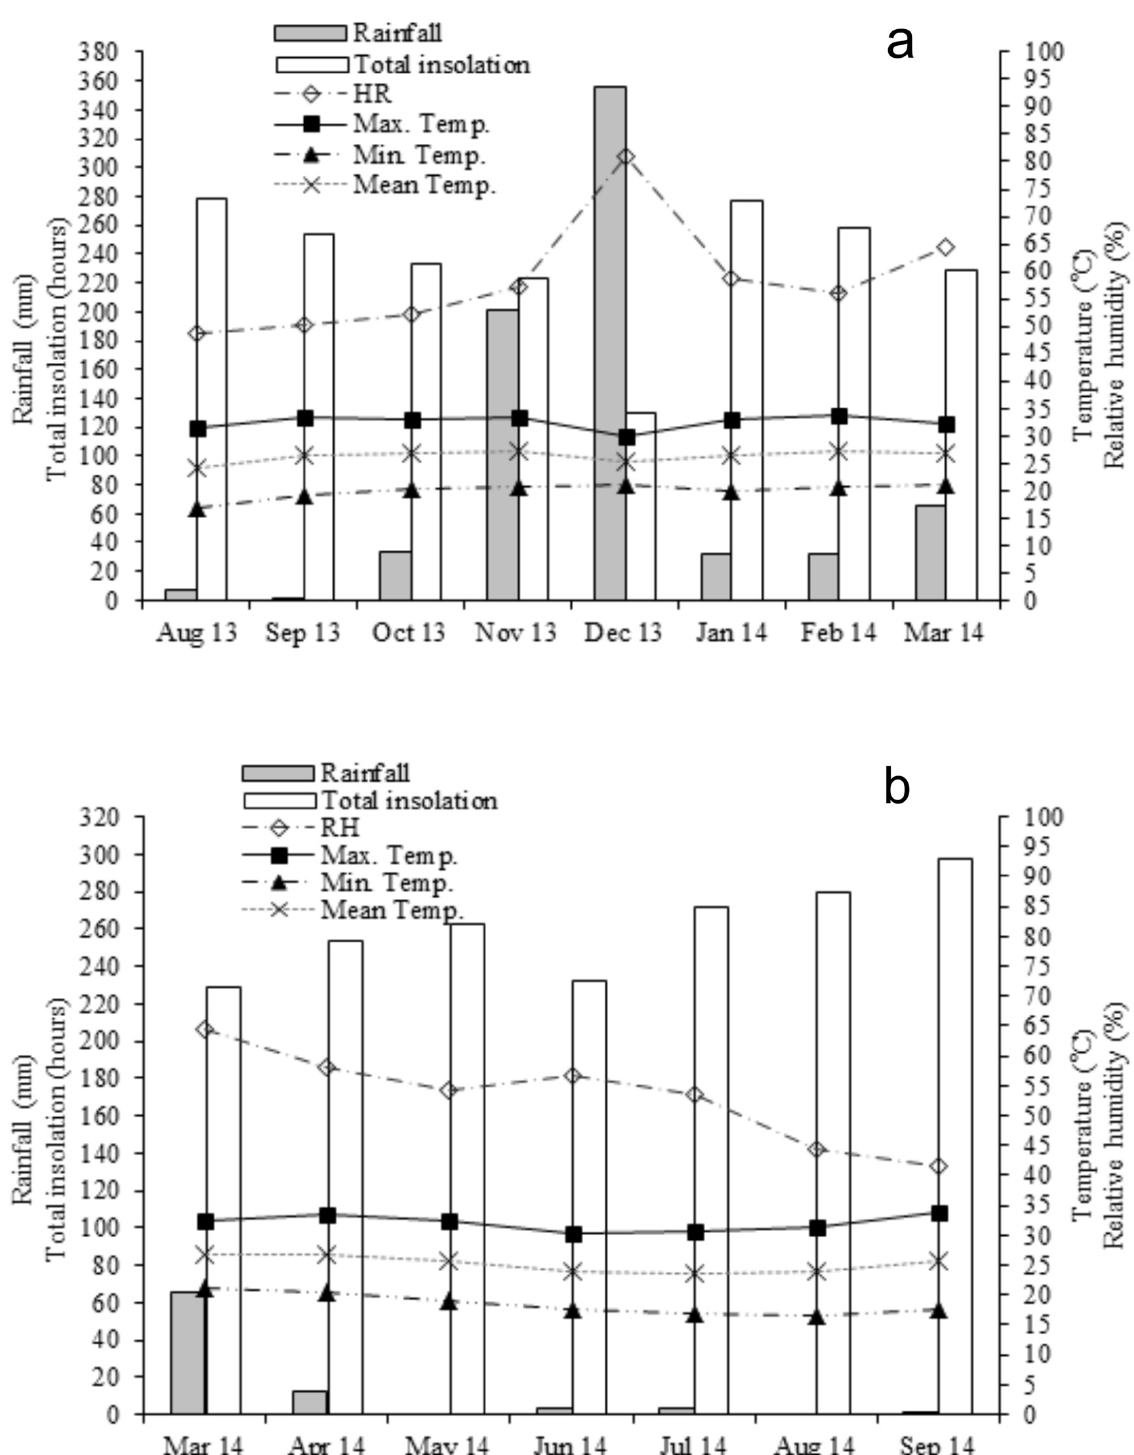
Figure 1 - Rainfall, total insolation, relative humidity and maximum, minimum and mean temperature during the ( a ) first and ( b ) second sugar-apple ( A. squamosa L.) crop cycles in Janaúba, Minas Gerais, Brazil,